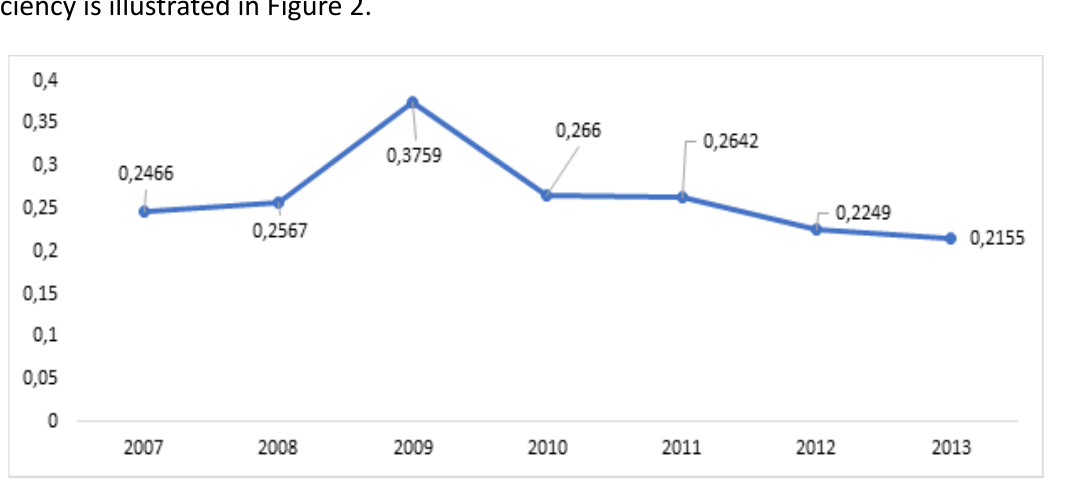
Figure 2: Technical Efficiency Scores Over